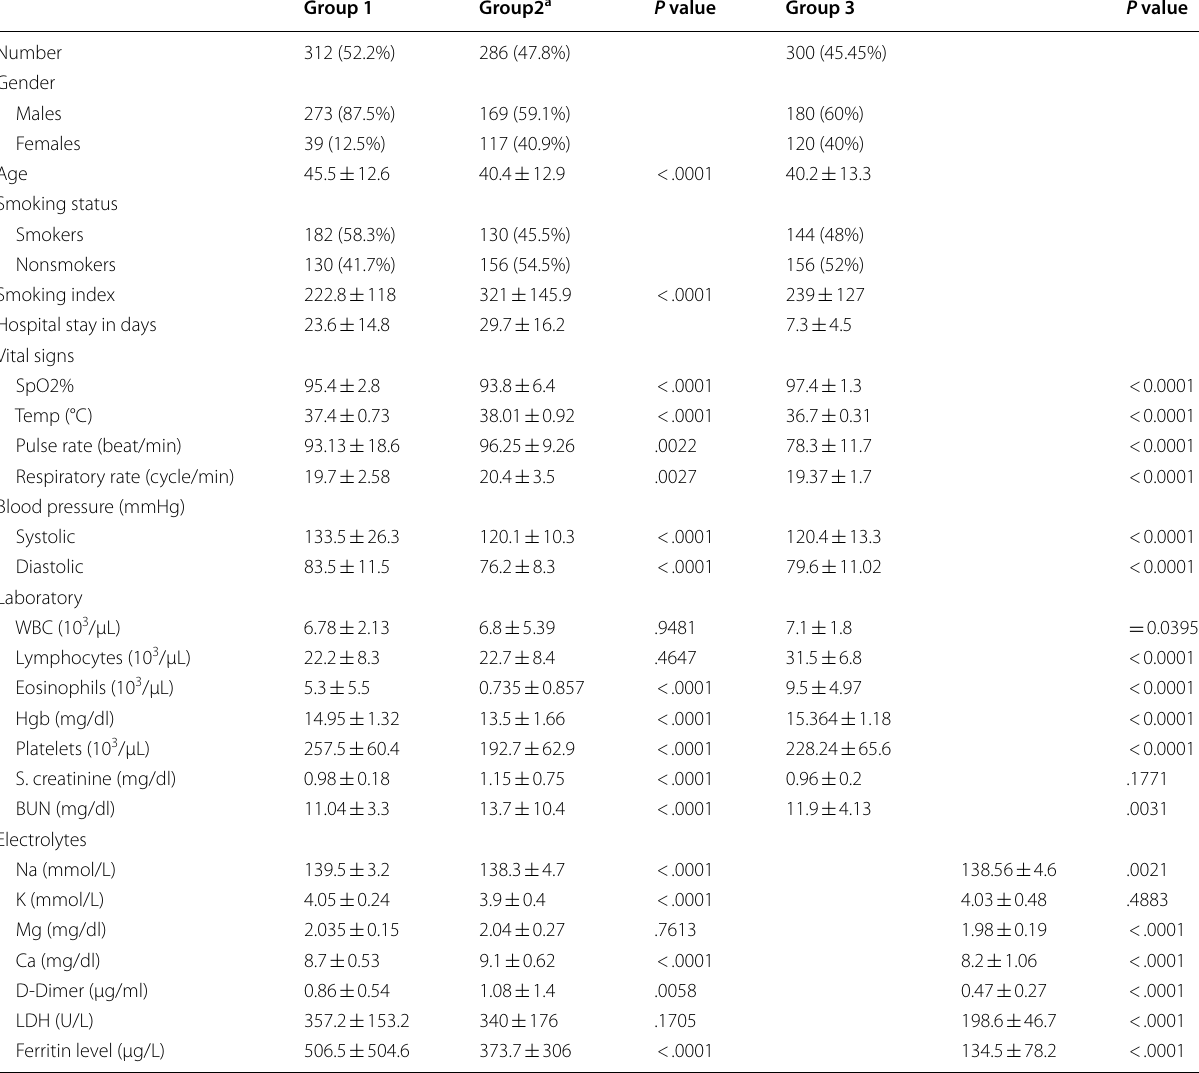
Table 1 Demographic, clinical, and laboratory data of the study groups